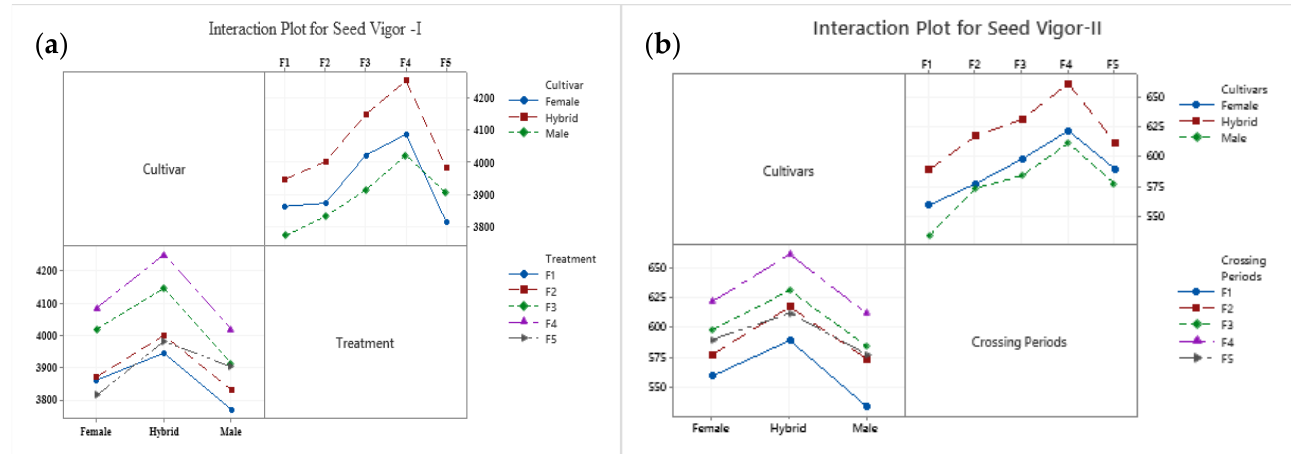
Figure 1. The seed vigor potential of bottle gourd hybrid HBGH-35 and two parental lines, female Pusa Naveen and male G2-line. ( a ) Seed vigor I and ( b ) seed vigor II.